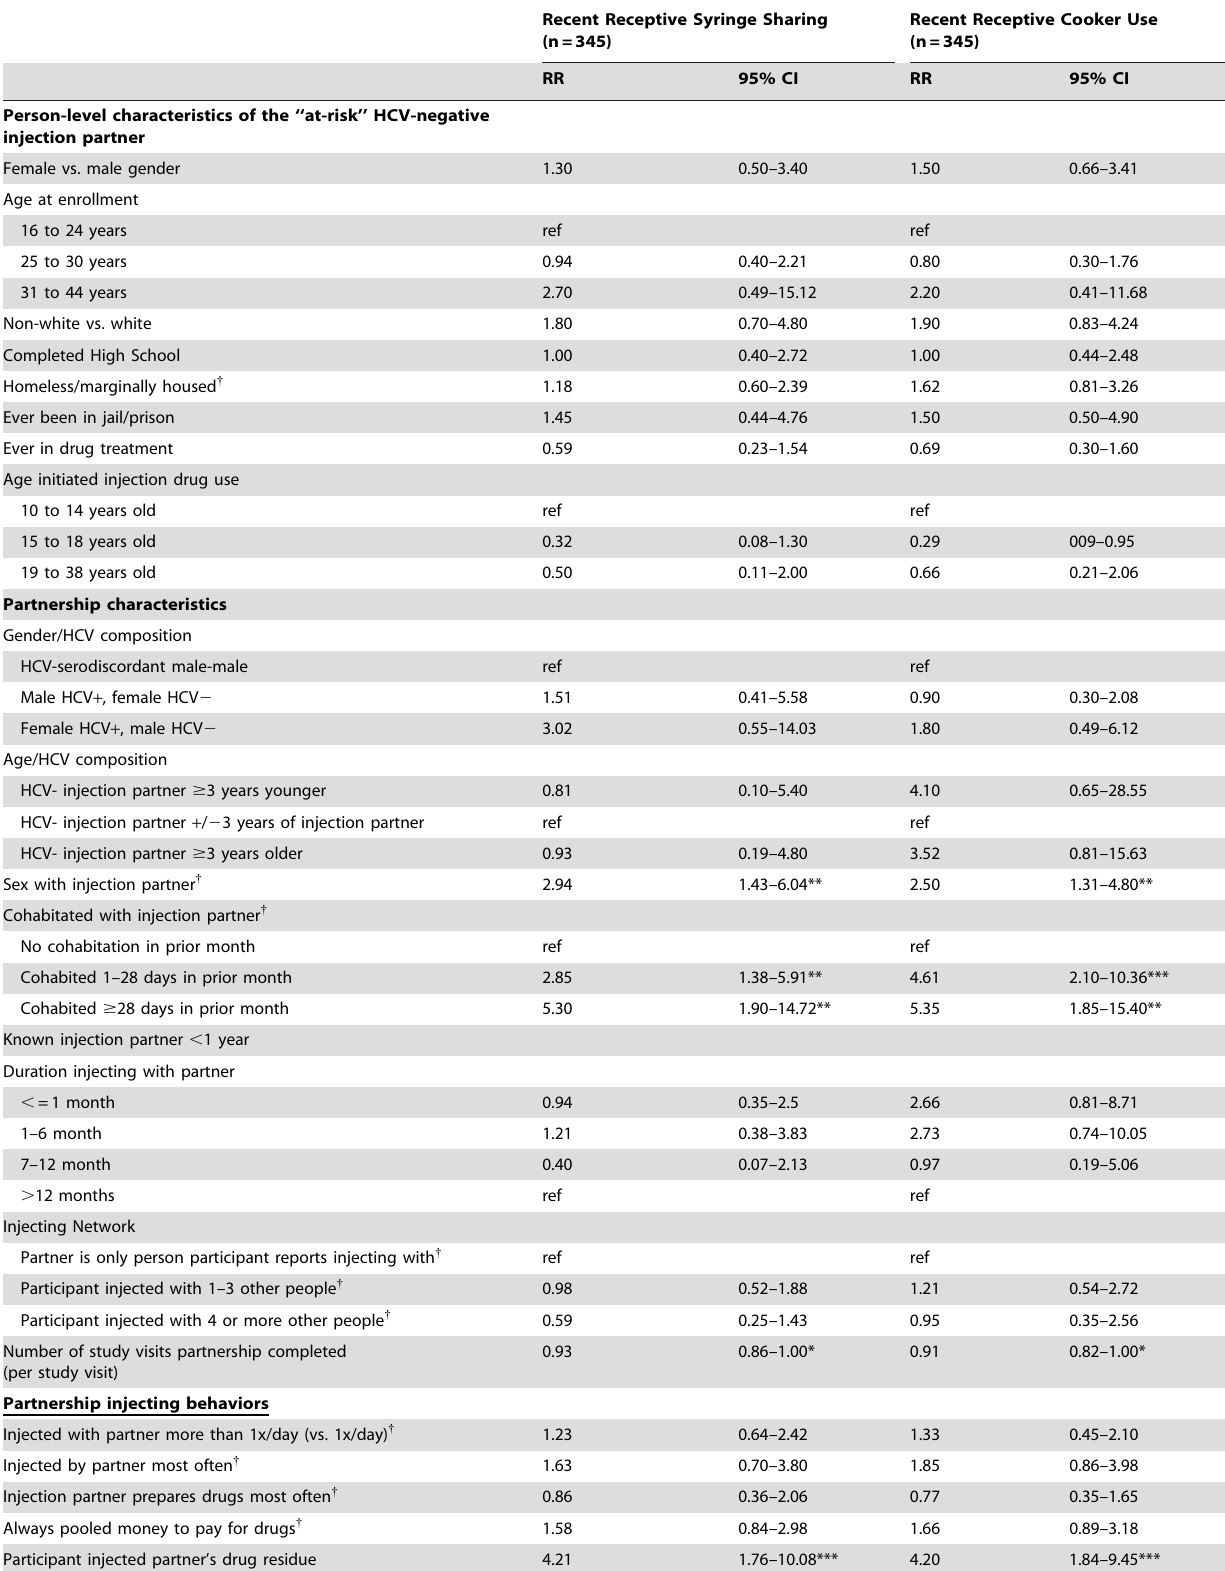
Table 3. Bivariate associations for characteristics associated with recent receptive syringe and cooker use.